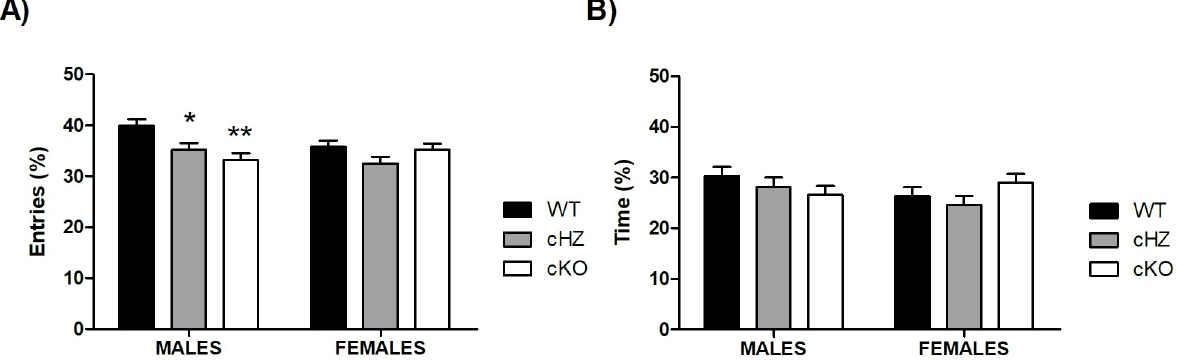
Fig 2. Anxiety-related behaviour: EPM. The bar plots represent the Mean and the SEM of the percentage of entries ( A ) and the percentage of time ( B ) in the open arms during the 5-minute trial. Three groups were compared: WT ( Grik4 Cre+/+ , SV2A lox/lox , n = 45), cHZ ( Grik4 Cre+/- , SV2A lox/+ , n = 47), and cKO ( Grik4 Cre+/- , SV2A lox/lox , n = 43), with Males (n = 22) and females (n = 23). ( � ) and ( �� ) indicates that both, cHZ and cKO groups are statistically significant to the WT group, as yielded by a Tukey HSD test taken at p < .05 and p < .01, respectively.